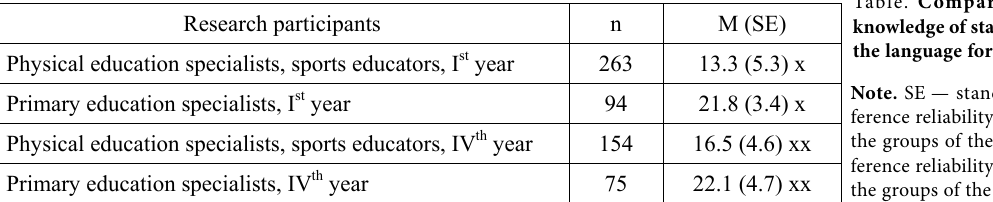
Table. Comparison of students’ knowledge of standard language and the language for special